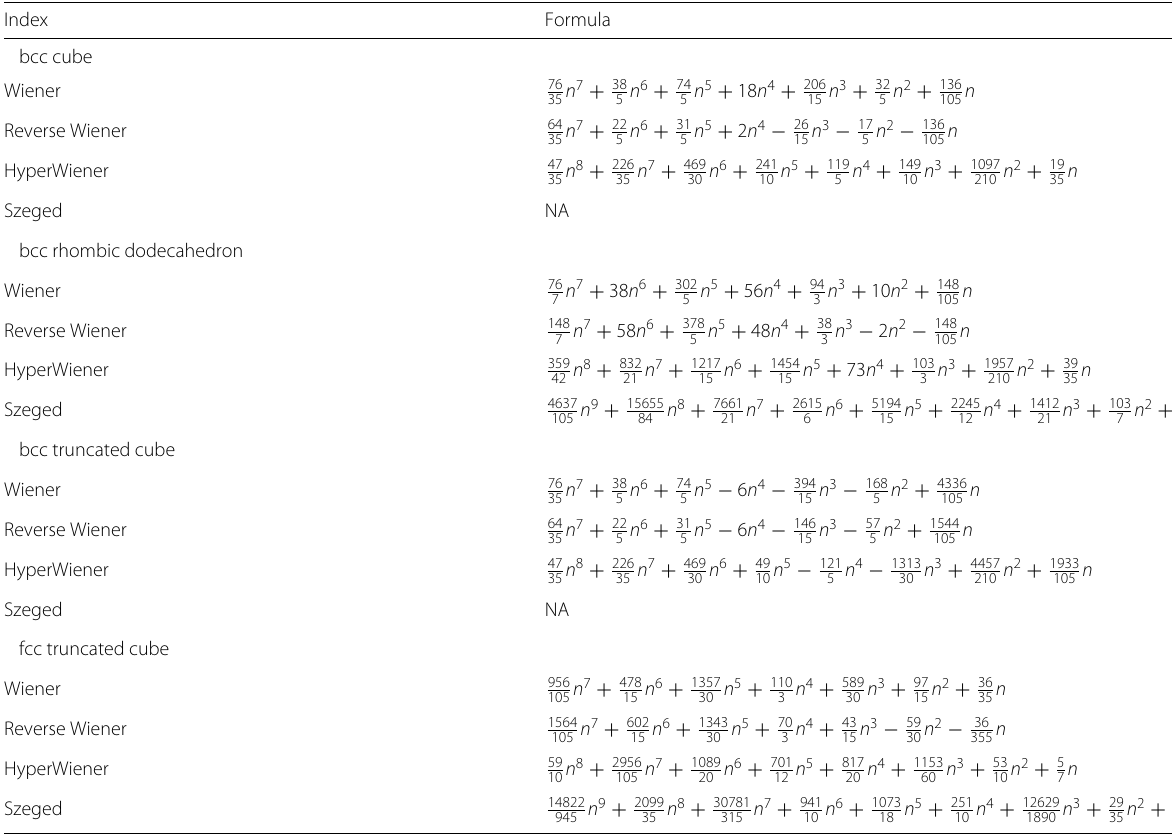
Table 9 Magic topological formulas for BCC and FCC